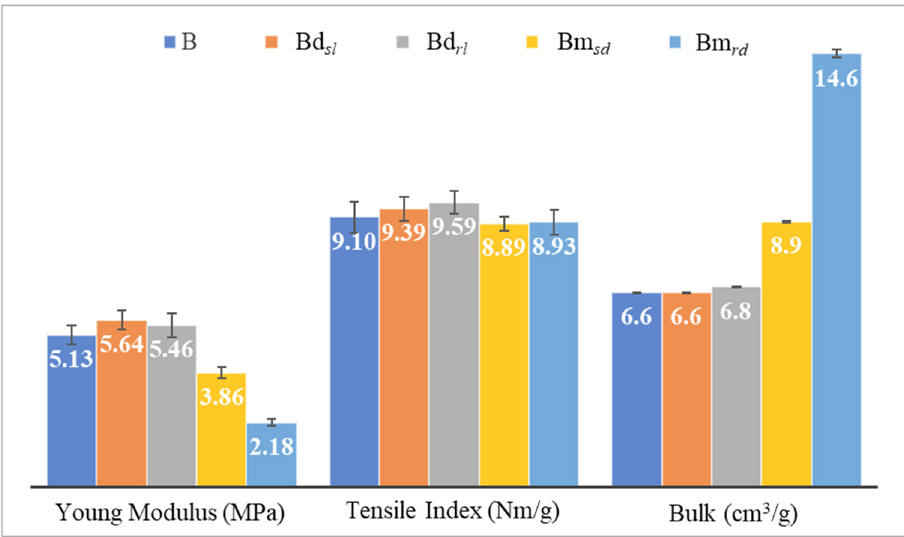
Figure 5. Results of mechanical characterization and bulk obtained for all the embossed samples and the reference paper, B, for the different finishing geometries of the 3D steel plates.